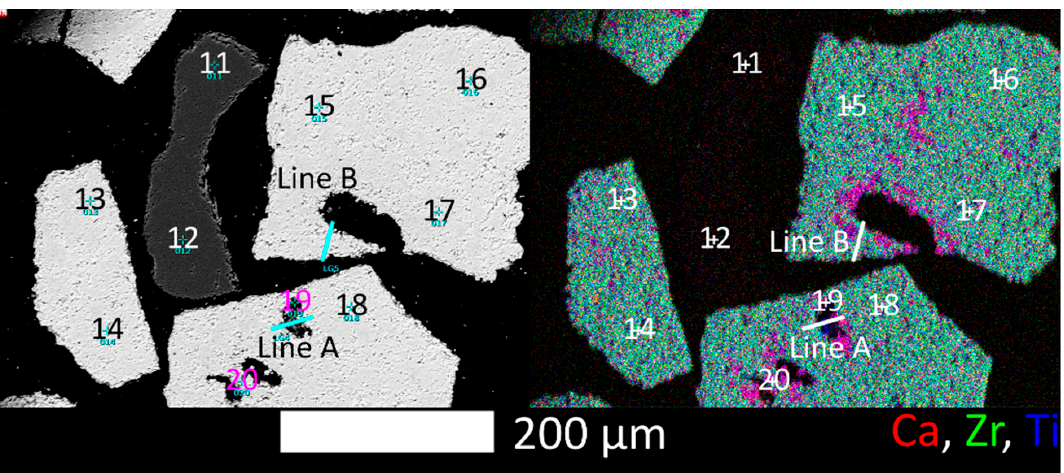
Figure 12. A large zirconolite particle with rutile inclusions after leaching in 0.25 M H 2 SO 4 at 85 °C for 5 h Left: BSE image, right: element map.